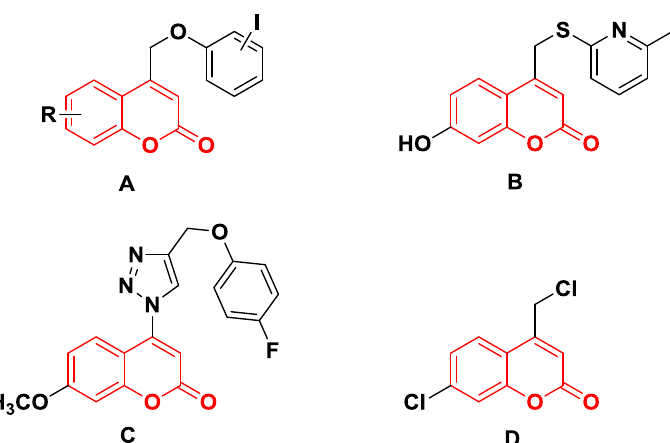
Figure 1. Structures of some 4-substituted coumarins. ( A ) the coumarins attached an iodinated aromatic ring. ( B ) the coumarin linked 6-methylpyridine. ( C ) the hybrid of 1,2,3-triazole and 4-subsitituted coumarin. ( D ) 4-substituted coumarins reported by supuran group.